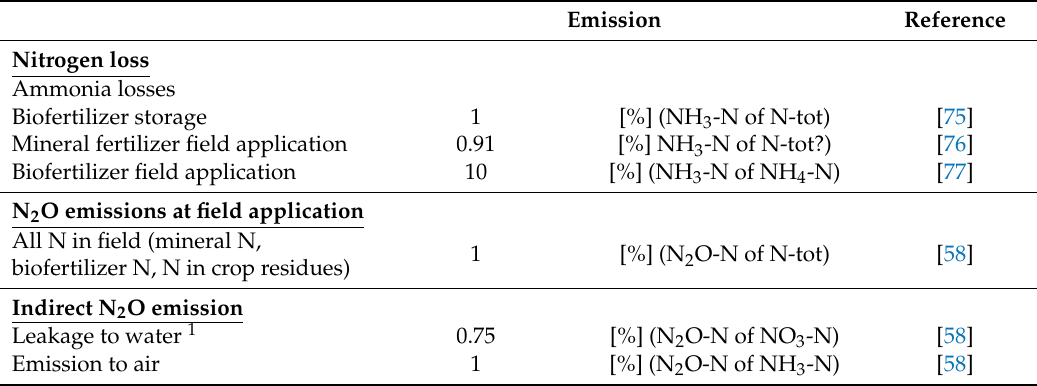
Table A19. Emissions resulting from field application of mineral fertilizer and biofertilizer.